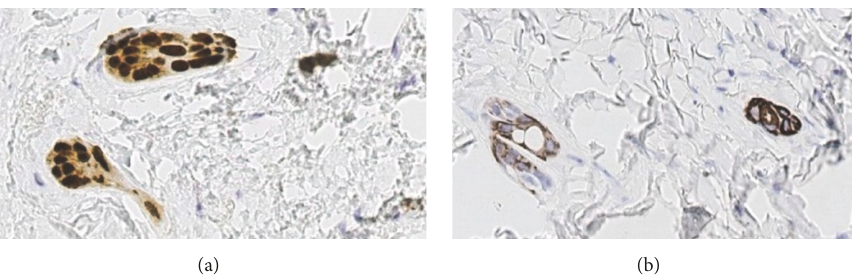
Figure 6: Micrograph of the immunohistochemical analysis showing positive reaction for P63 (a) and CK7